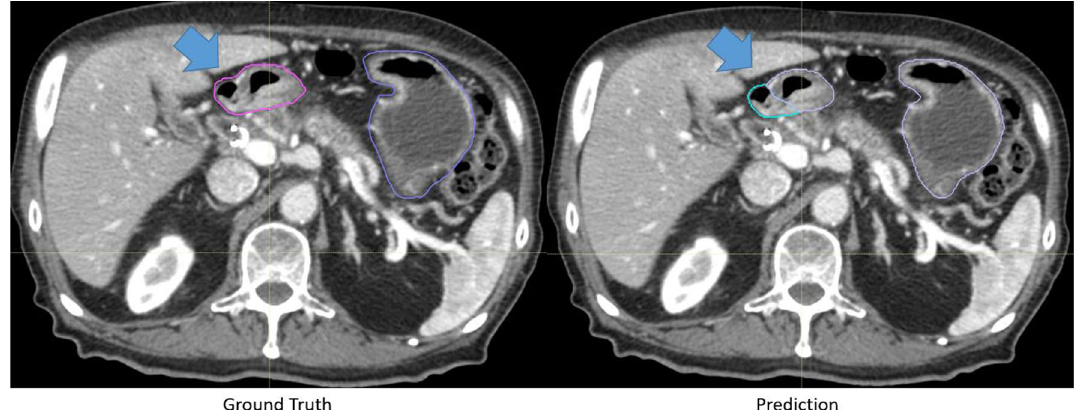
Figure 5. Representative ground-truth (left) and the automatically generated (right) contour of a patient’s duodenum and stomach. These contours differed significantly, but because the duodenum and stomach are often optimized using the same dose constraints (i.e. Dmax < 28 Gy), the contours were scored as a 4 and deemed acceptable for treatment